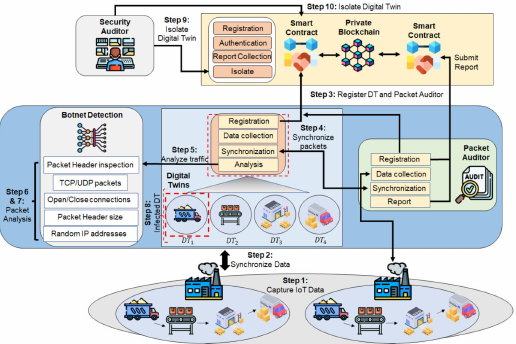
Figure 1. Blockchain-enabled Secure Digital Twin framework